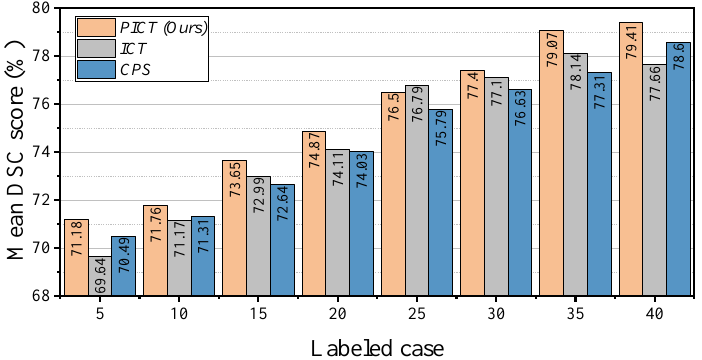
14 of 19 Figure 8. Representative cases of three methods on CTPelvic1k dataset. The green, blue, yellow, and red parts of the visual model represent the left hip bone, right hip bone, lumbar spine, and sacrum, respectively. 4.3. Performance Comparison on Multi-Tissue Pelvic1k This paper further studied the segmentation performance of the proposed method